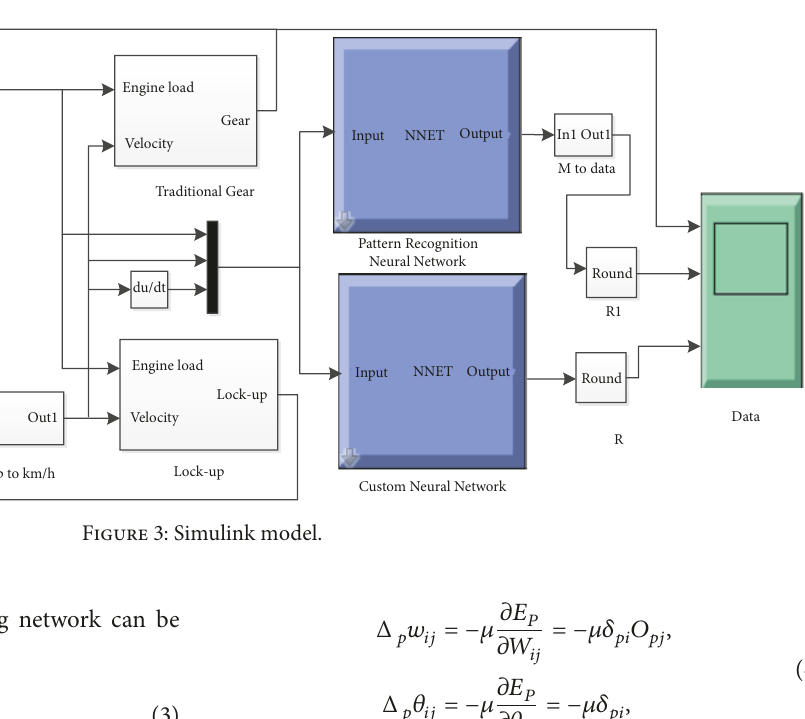
Figure 2: AMESim model.